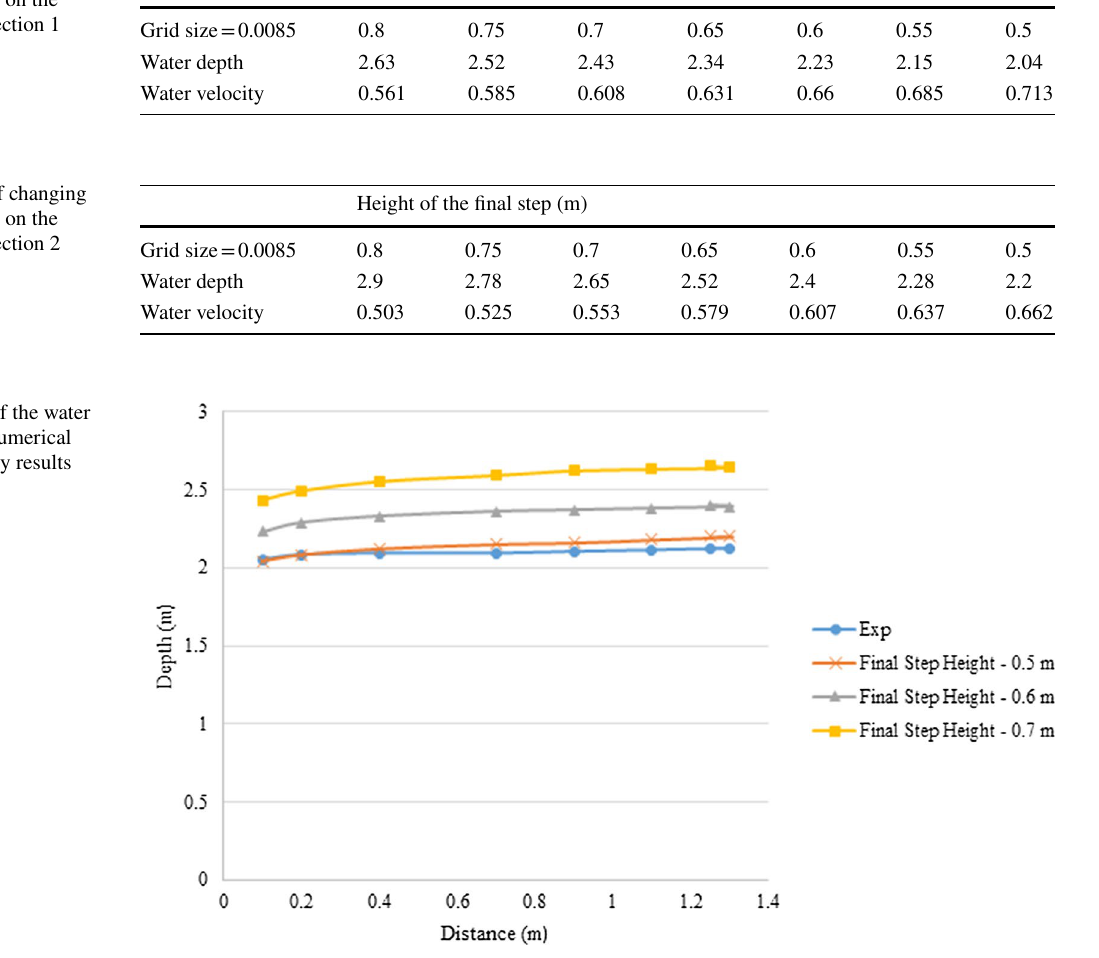
Height of the final step (m)